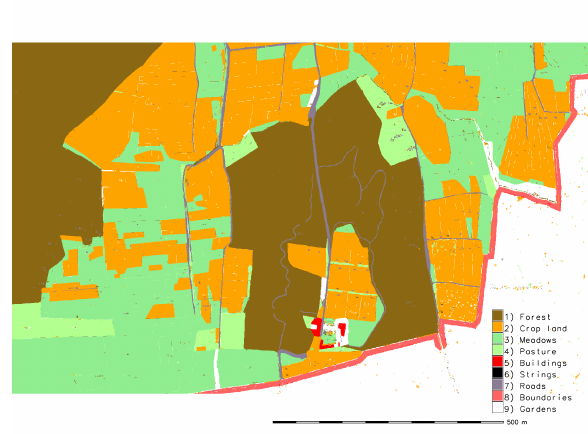
Figure 8. Classified map for unsupervised MLC after text and symbols removal - particular.